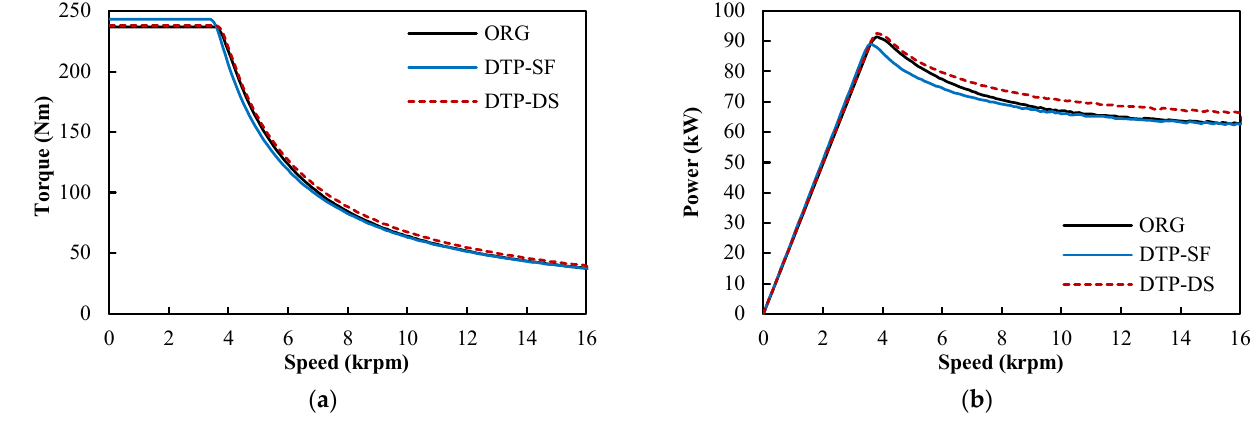
Figure 28. Torque– and power–speed envelopes of different winding configurations: ( a ) torque–speed envelope; ( b ) power–speed envelope.